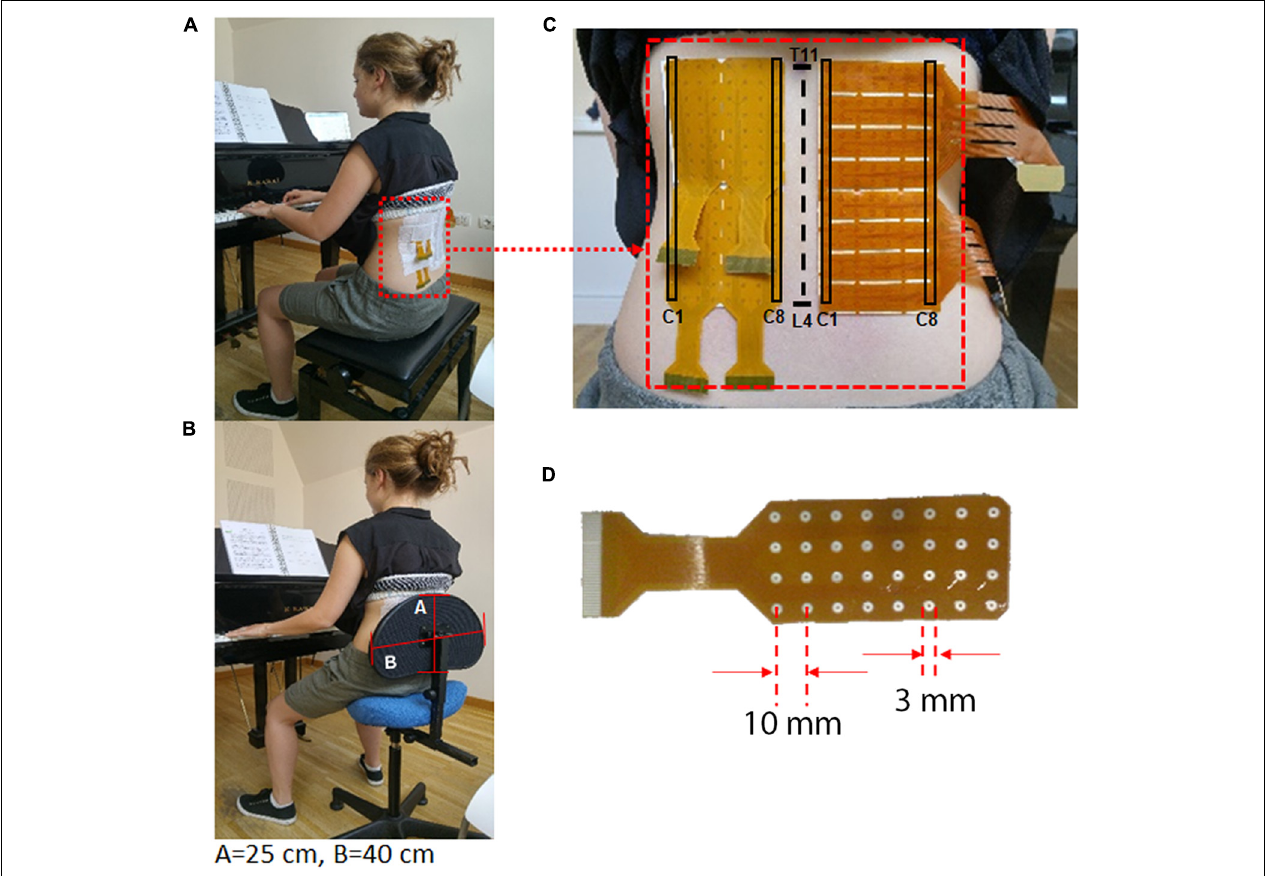
FIGURE 1 | (A) Pianist playing on the SS (standard piano stool) keeping the trunk erect with a trunk-thigh angle of 90 ◦ ; (B) Pianist playing on the A-Chair keeping the trunk erect, with a trunk-thigh angle between 105 ◦ and 135 ◦ . The pianist back is always in contact with the lumbar support which has a dimension of A = 25 cm by B = 40 cm; (C,D) An example of electrode grid positioned on the lumbar portion of the right and left ESM (between spinal processes T11 and L4). The grids have an inter-electrode distance = 10 mm and electrode diameter Ø = 3 mm. The first (C1) and last (C8) columns of the electrode grids are